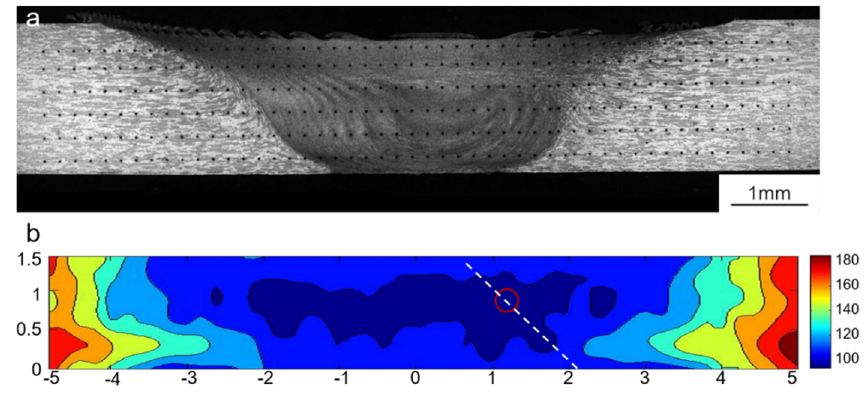
Figure 13: ( a ) Points of Vickers hardness test of C2; ( b ) Microhardness mapping of